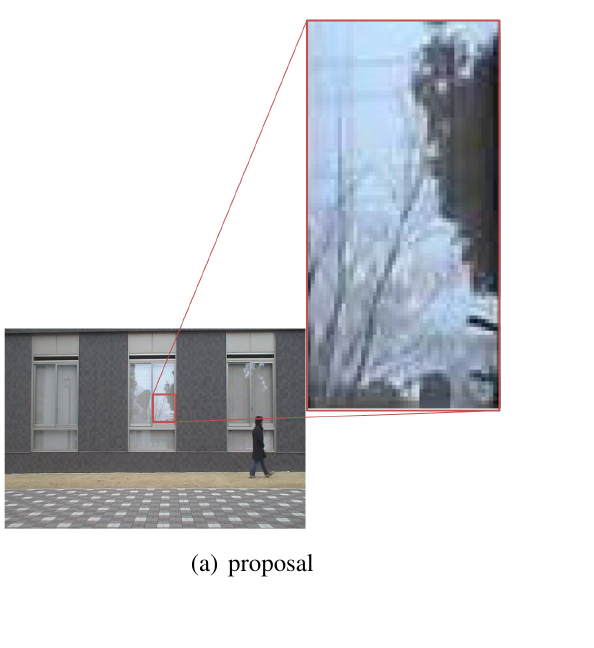
Figure 20 . Perceived video image sent from node C at 40